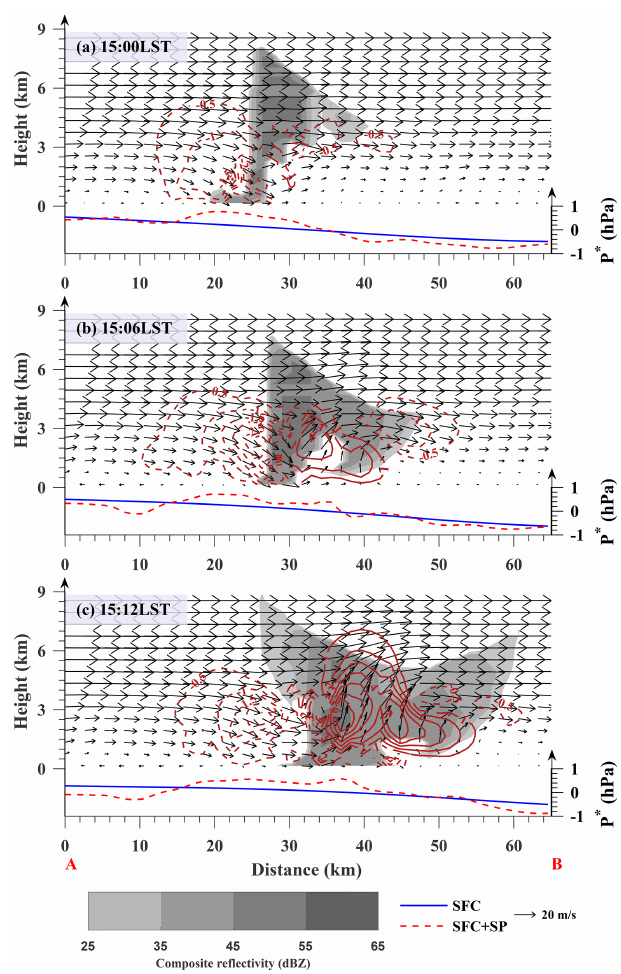
Figure 15. Vertical cross section of the radar reflectivity (shaded), VDRAS wind field (thin black arrows) and vertical velocity field (brown contours with dash lines for downward motion and solid lines for upward motion) along the line A–B in Fig. 10. The solid blue line and dashed red line are the surface pressure perturbation along the A–B line from SFC and SFC + SP,